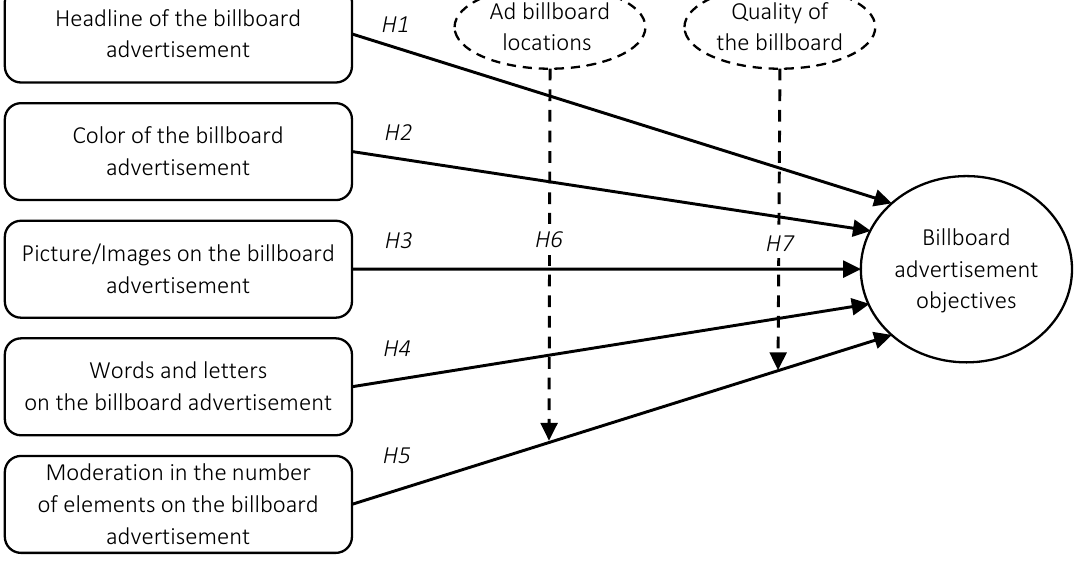
Figure 1. Proposed research